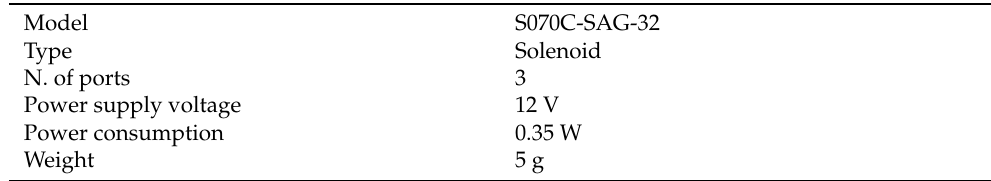
Table 3. Specifications of the 3-way valve.